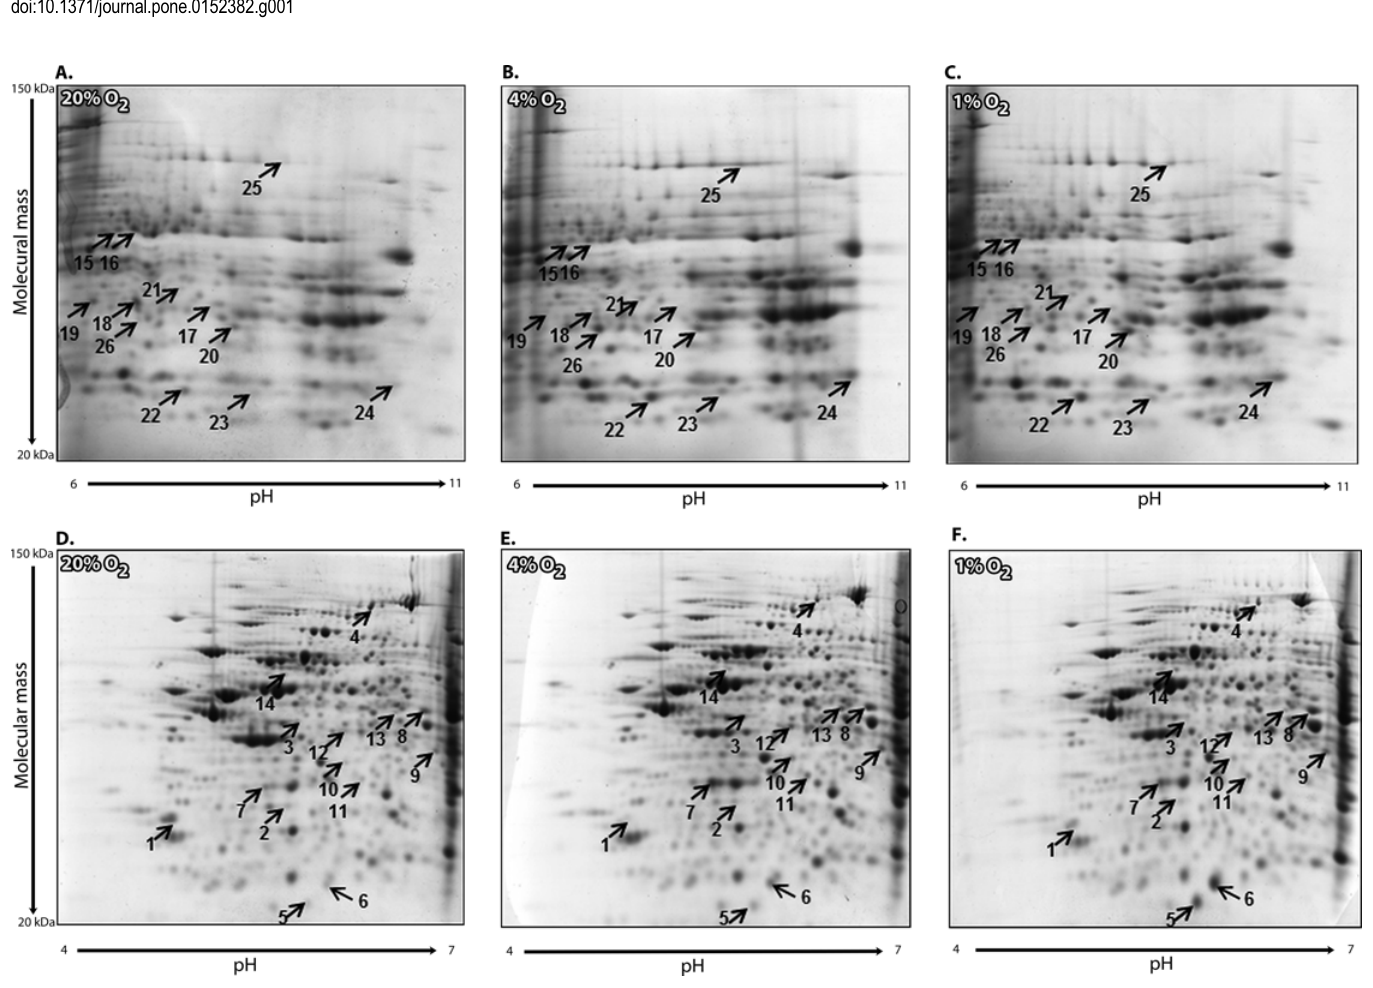
Fig 2. Representative examples of 2-DE gels. Representative 2-DE gels of 3T3-L1 differentiated preadipocytes exposed to 1% and 4% hypoxia compared to control exposure (20%). Gels contain visualized proteins with isoelectric point within pH range 6 – 11 (A, B, C) and 4 – 7 (D, E, F). Differentially expressed proteins are marked by arrows and